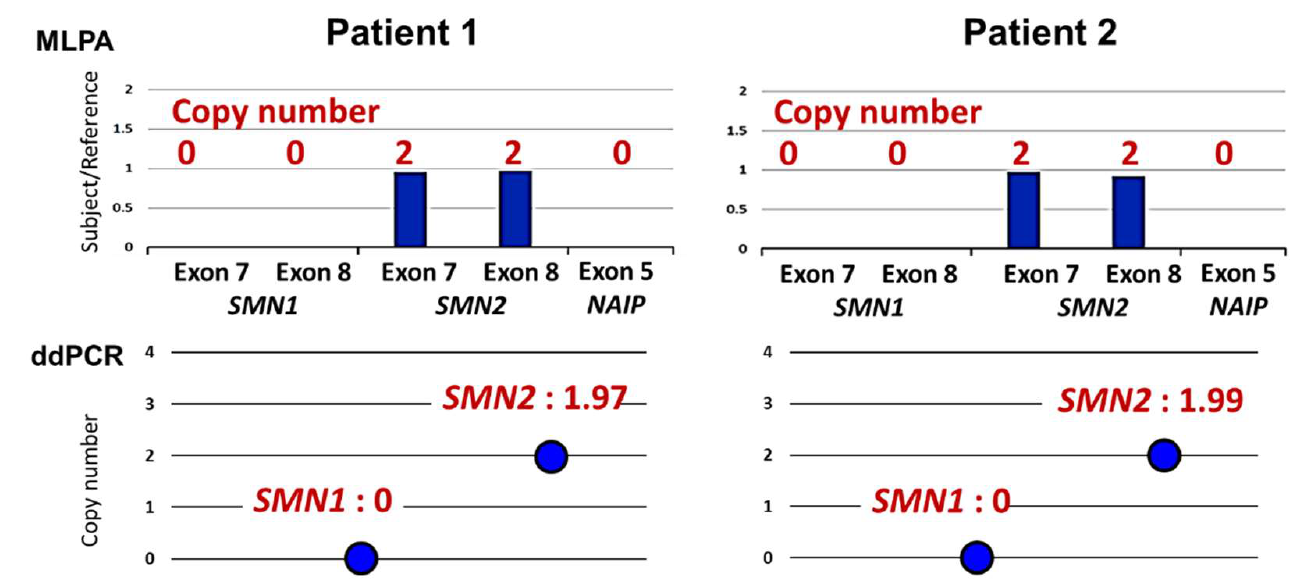
Figure 2. MLPA and ddPCR analyses of patients identified by SMA-NBS. Multiplex ligation- dependent probe amplification (MLPA) showed that both patients carried homozygous deletion of SMN1 exons 7 and 8 and two copies of SMN2 exons 7 and 8. They also showed homozygous deletion of NAIP exon 5 on MLPA analysis. NAIP : the neuronal apoptosis inhibitory protein gene. Droplet digital PCR (ddPCR) showed that both patients carried homozygous deletion of SMN1 exons 7 and two copies of SMN2 exons 7, which was consistent with the results of MLPA